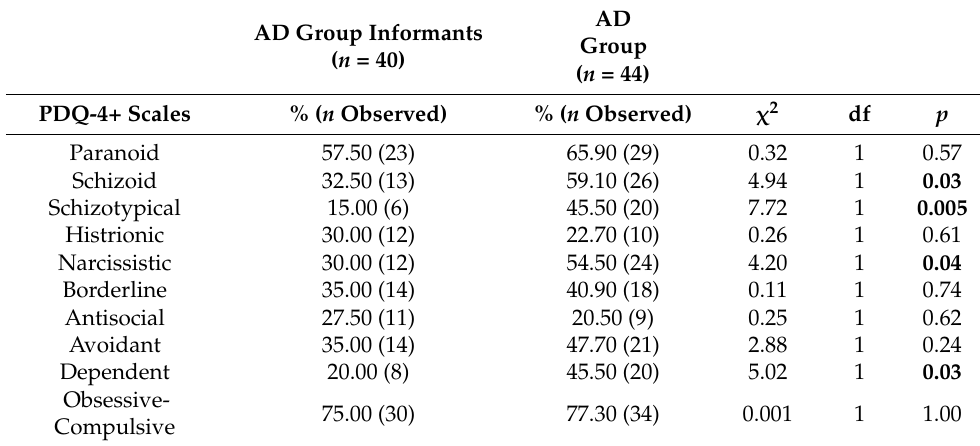
Table 3. Chi-square Test of Homogeneity between the AD Group Informants and the AD Group for Diagnosis of the Ten Scales of the PDQ-4+.